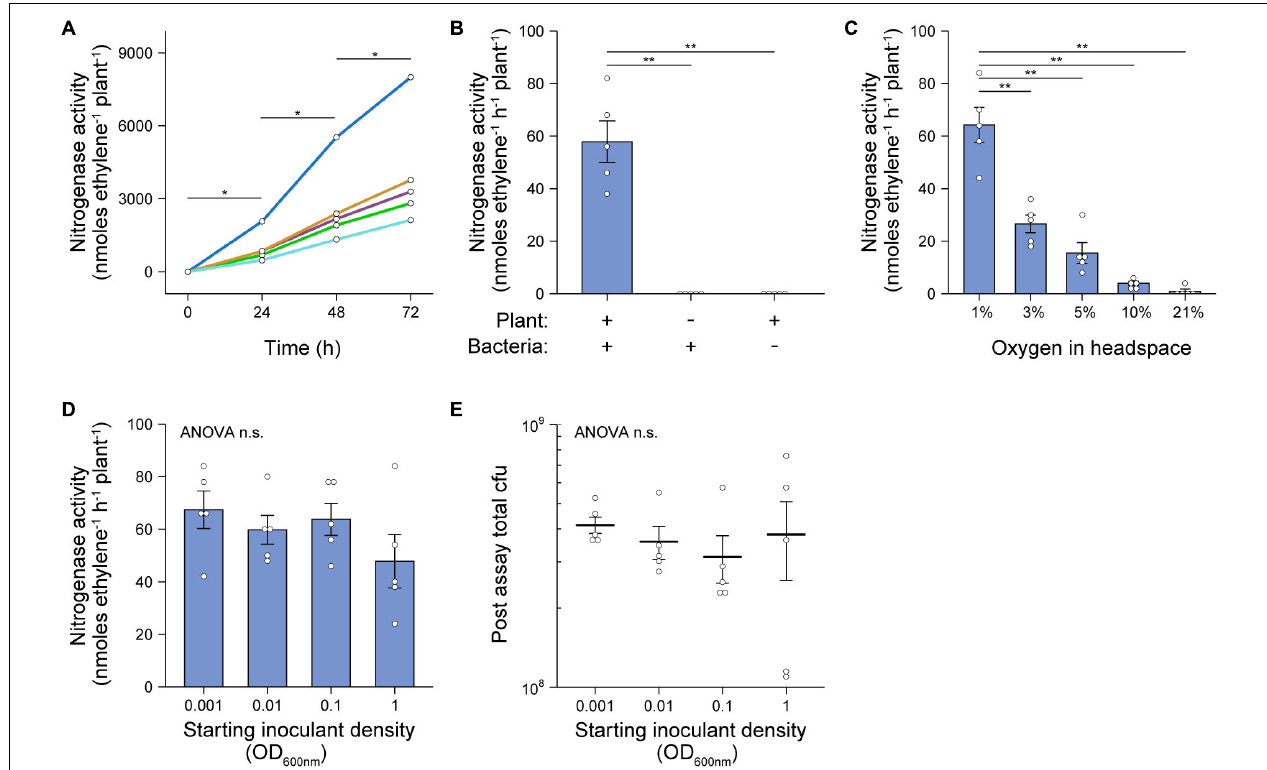
FIGURE 2 | Validation and optimization of in situ ARA. A. caulinodans ORS571 ( Ac ) was used as the model strain for these experiments. The assays were set up by sewing individual pre-germinated, surface-sterilized barley seeds into 100 mL Schott bottles containing industrial grade sand and N/C-free rooting solution, inoculating the plants with 2 mL of an OD 600 nm 0.1 suspension of Ac , then growing the plants in a growth-chamber for 6-days. At this point, the atmosphere in the headspace was adjusted to 1% O 2 , the bottles were sealed with a rubber septum and 10% of the headspace was replaced with C 2 H 2 . Bottles were returned to the growth chamber and the reduction of acetylene (C 2 H 2 ) to ethylene (C 4 H 4 ) by nitrogenase was measured at 24-intervals over 72-h using GC-MS. Mean ± SEM (error bars) and individual values for five biological replicates are plotted. Nitrogenase activity was calculated between 24-h and 48-h. ANOVA and pairwise two-tailed students t -tests with Bonferroni adjusted P -values were used to compare means where relevant. P > 0.05 not significant (n.s.), * P < 0.05, ** P < 0.01, *** P < 0.001. (A) C 2 H 4 production in each of five biological replicates was monitored over 72-h. (B) Rates of nitrogenase activity where measured when the plant or bacteria was omitted from the system. (C) Rates of nitrogenase activity were measured when the starting O 2 concentration in the headspace was adjusted between 1 and